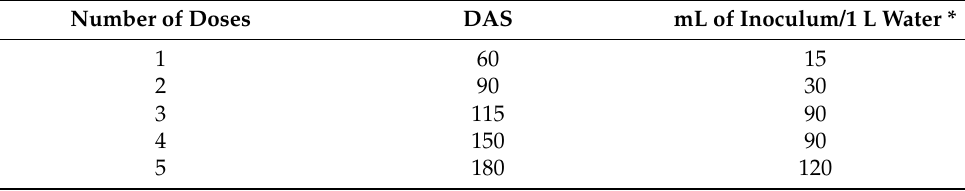
Table 1. Dosage of Bacillus sp. inoculum in tarwi plants. Number of Doses DAS mL of Inoculum/1 L Water * 1 60 15 2